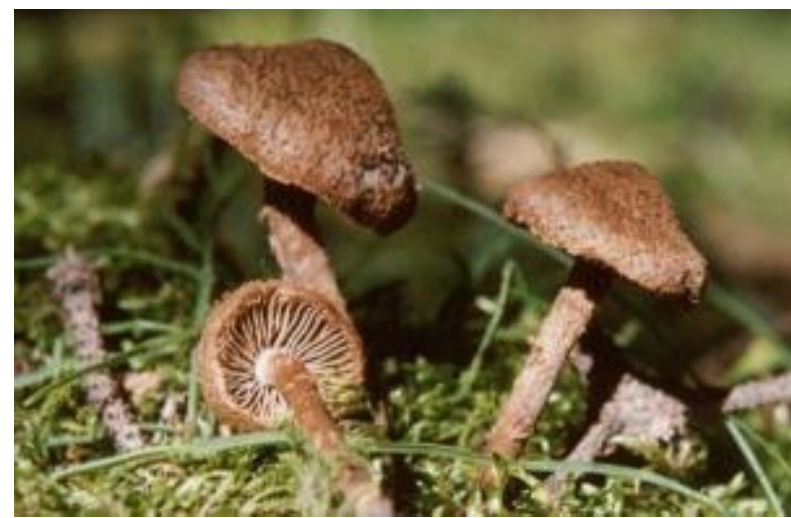
Figure 1. Inocybe